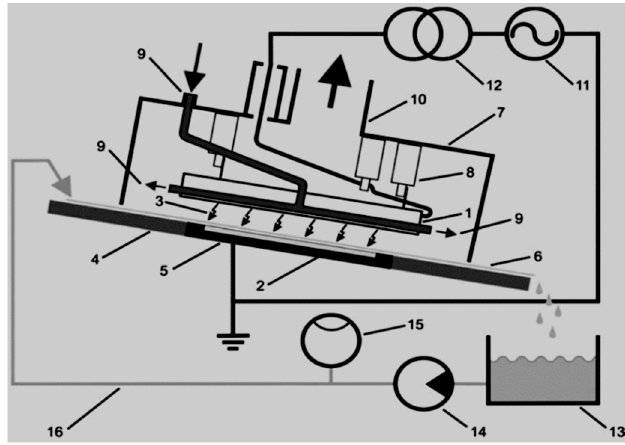
Figure 4. Diagram of the flow-through reactor. 1—barrier electrodes; 2—catalytic counter-electrodes;